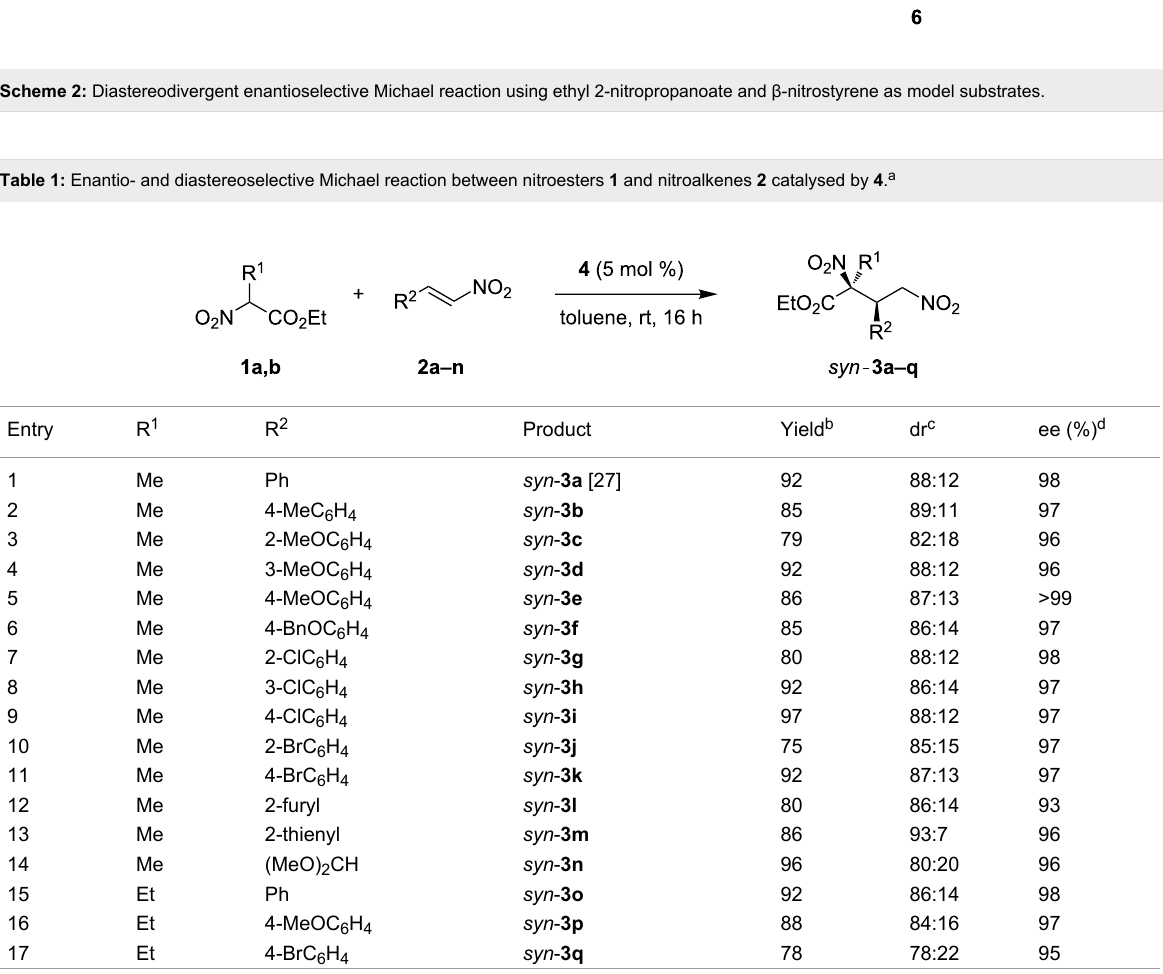
a All reactions were carried out on a 0.1 mmol scale of 1 and 2 in toluene (1 M) at room temperature using 5.0 mol % of 4 as catalyst. b Yield of pure Michael adducts as mixture of diastereoisomers after flash column chromatographic purification. c Determined by 1 H NMR analysis of the crude reac- tion mixture. d Determined by HPLC on a chiral stationary phase (see experimental part in Supporting Information File 1 for